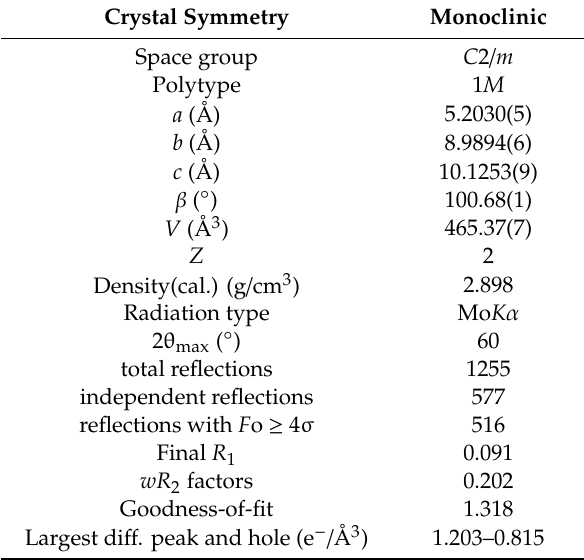
Table 3. Crystallographic data and refinement results for fluorluanshiweiite. Crystal